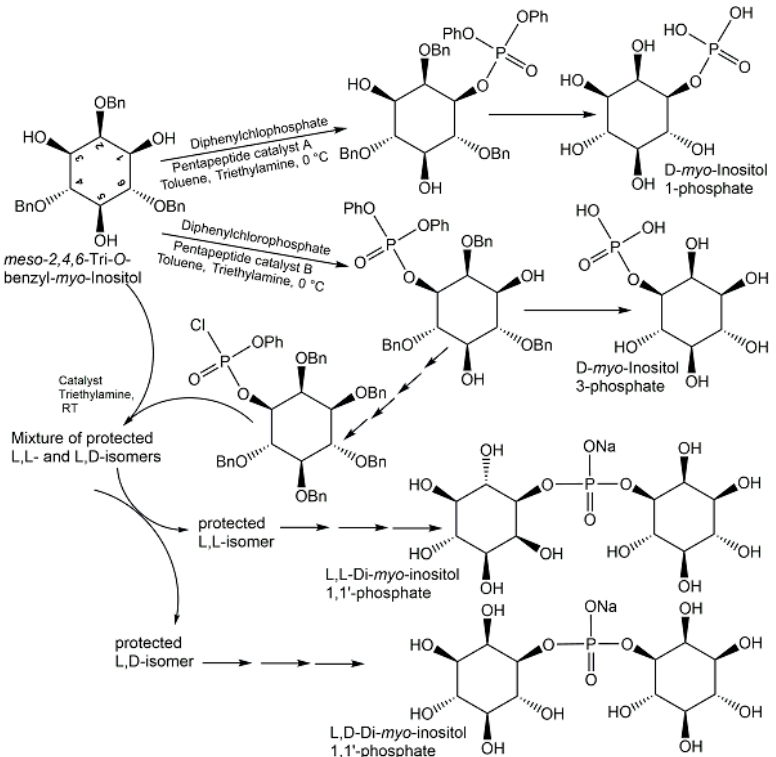
Figure 16. Chemical synthesis of D- myo -inositol 1-phosphate, D- myo -inositol 3-phosphate, L,L-, and L,D-di- myo -inositol 1,1 ′ -phosphate.